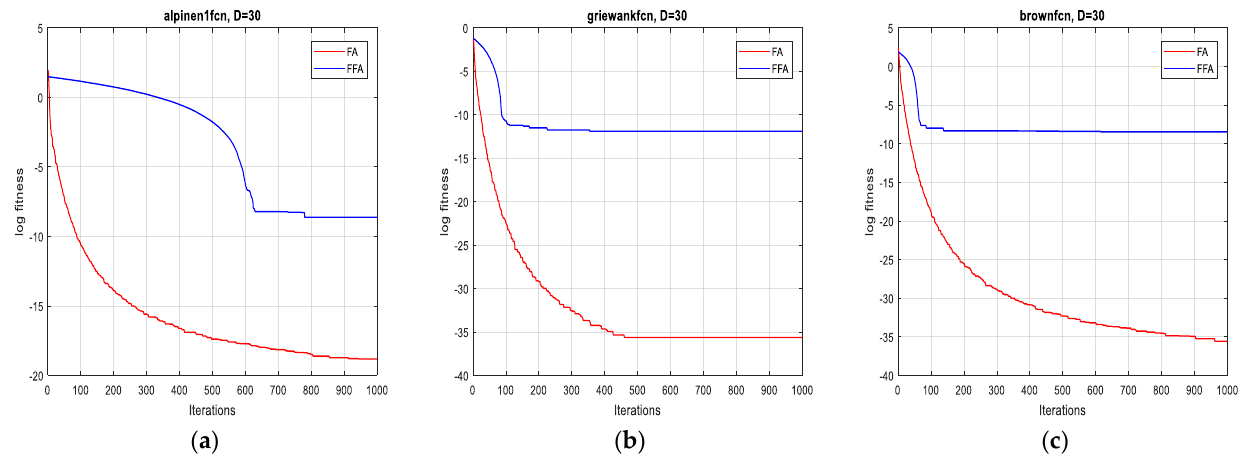
Figure 3. Convergence curves of FFA and FA for the functions: ( a ) F7; ( b ) F8 and ( c ) F9 (20D).